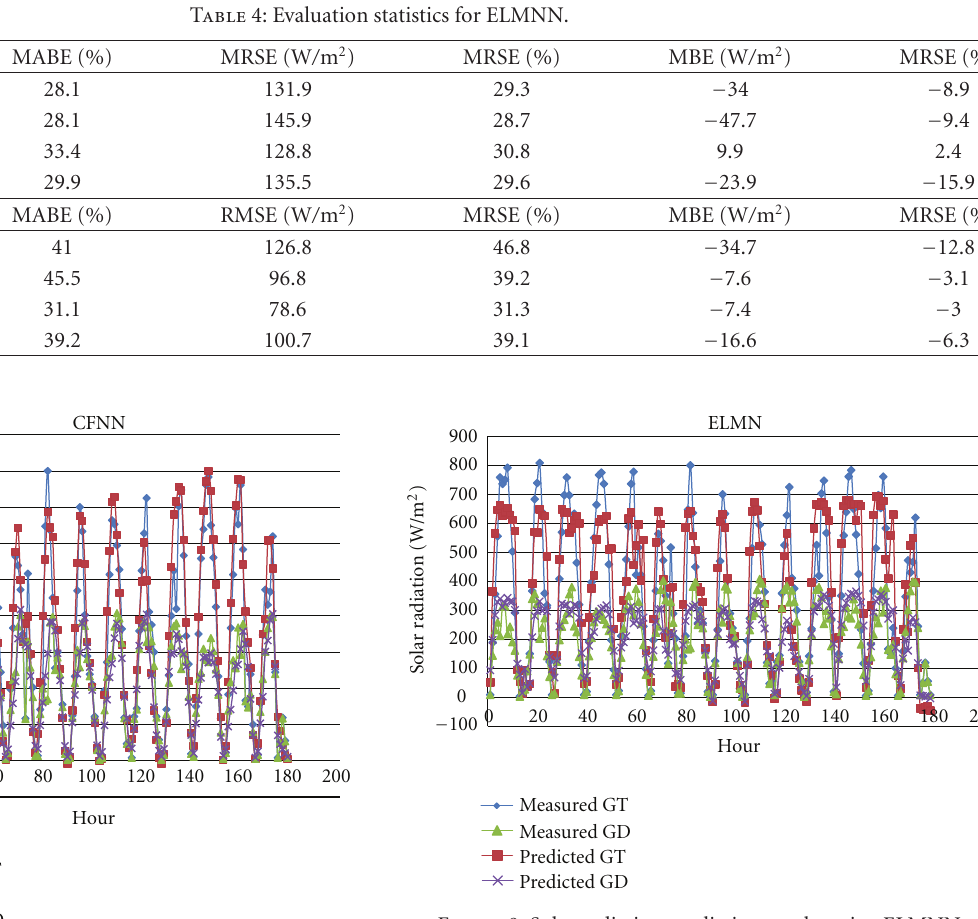
Figure 8: Solar radiation prediction results using